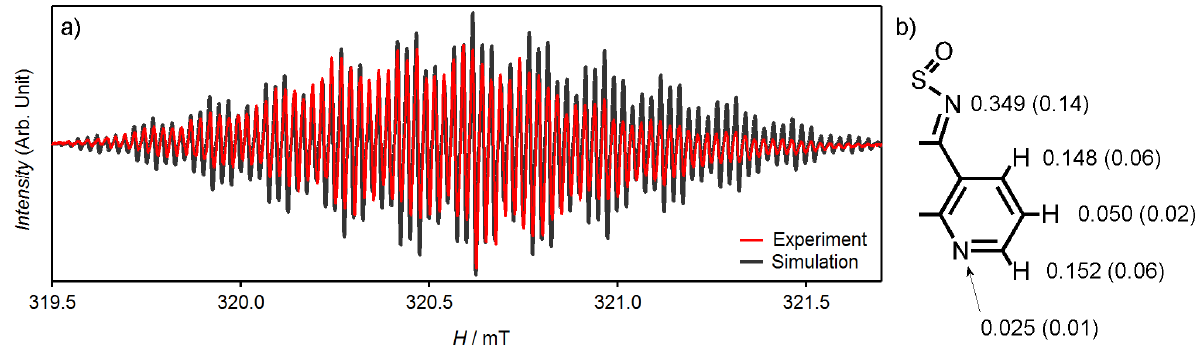
Figure 15. Experimental (red) and simulated (gray) solution EPR spectra of mono-anionic . The inset shows the hyperfine coupling constants in units of mT used for the tdapO 2 simulation, and in parentheses, the estimated spin density on the nitrogen and carbon atoms. Adapted with permission from [48]. Copyright 2011 American Chemical